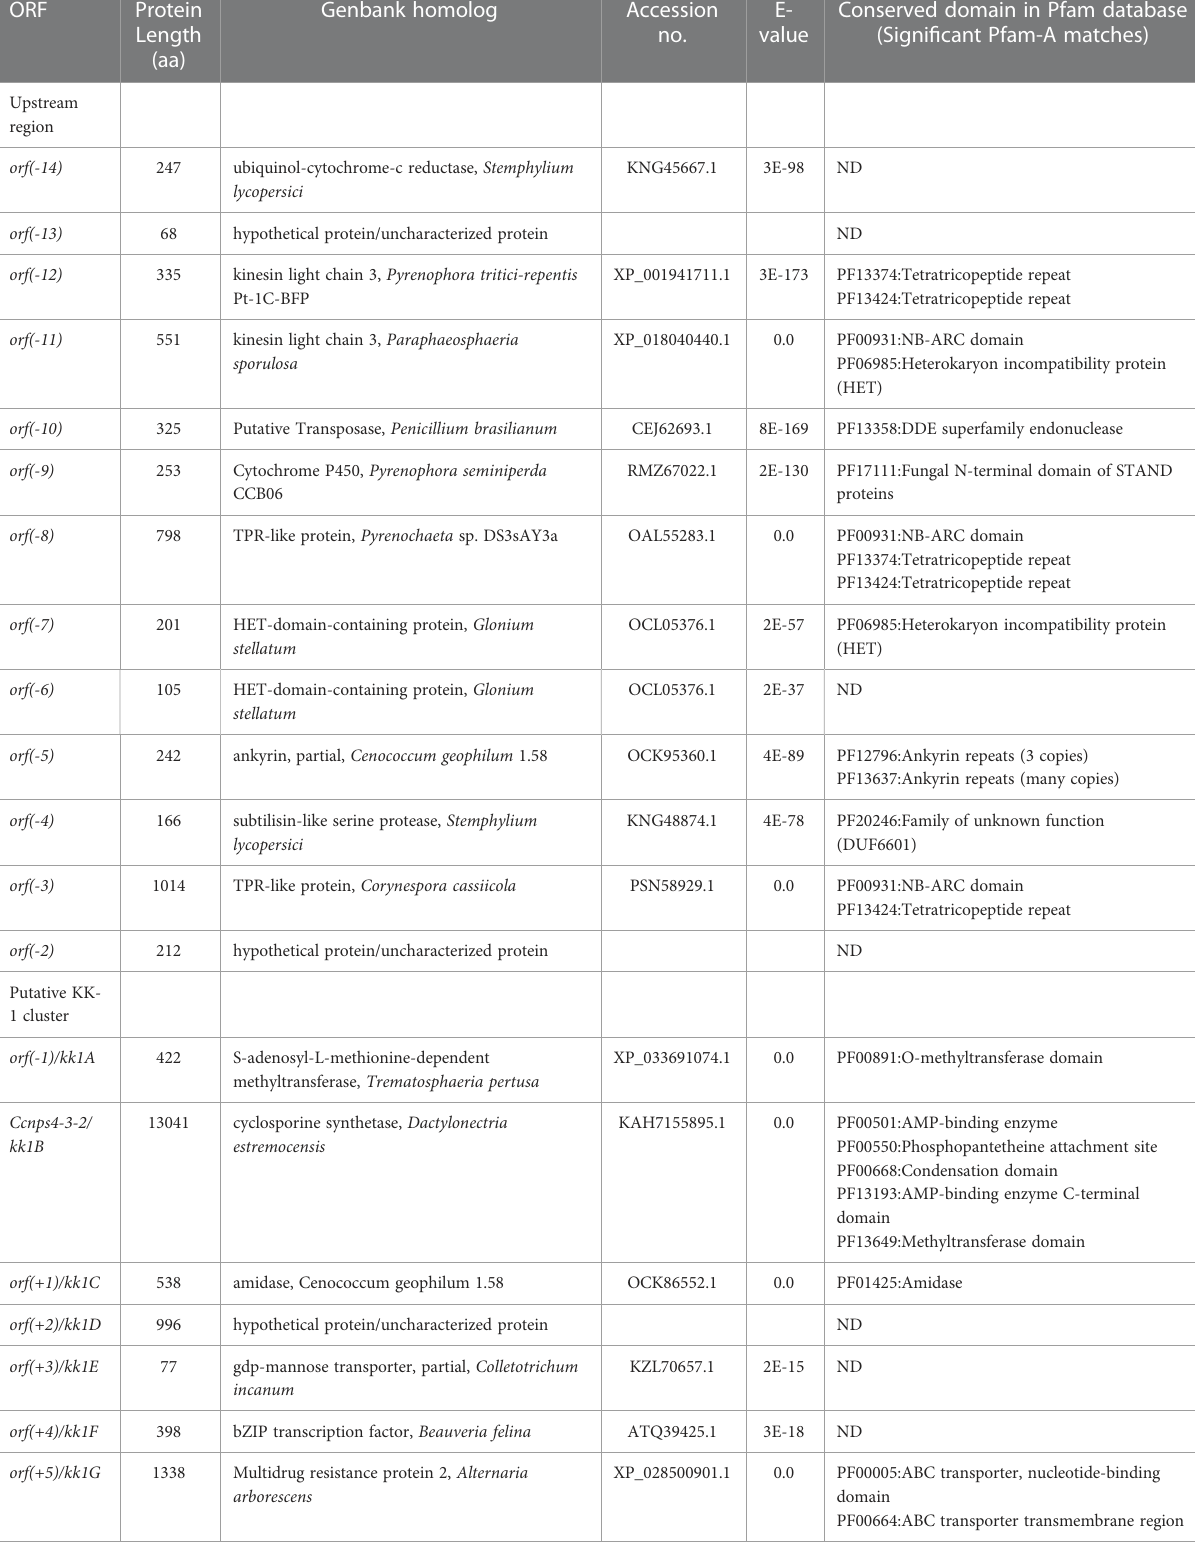
TABLE 1 C. clavata BAUA-2787 open reading frames (ORFs) around Ccnps4-3-2